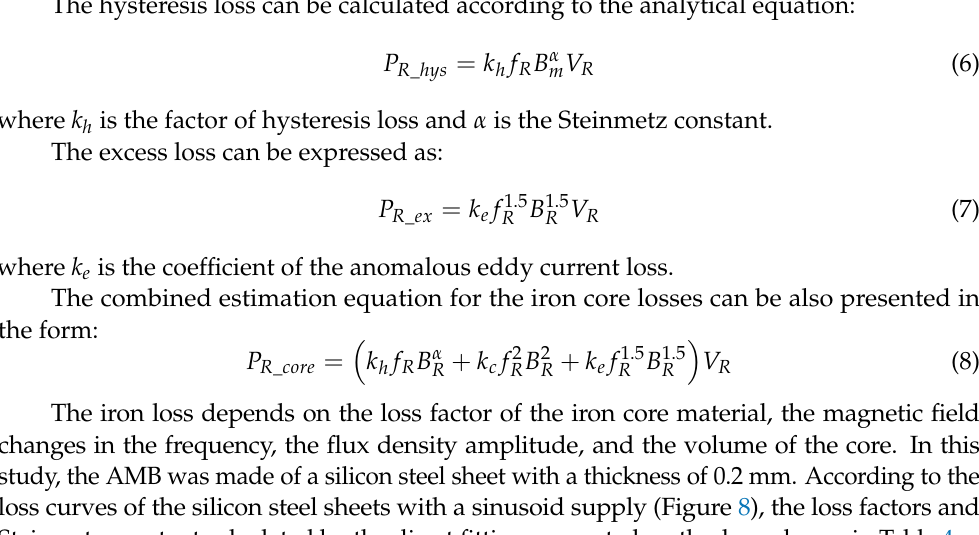
Table 3. Copper loss calculation for the AMB (20 °C).